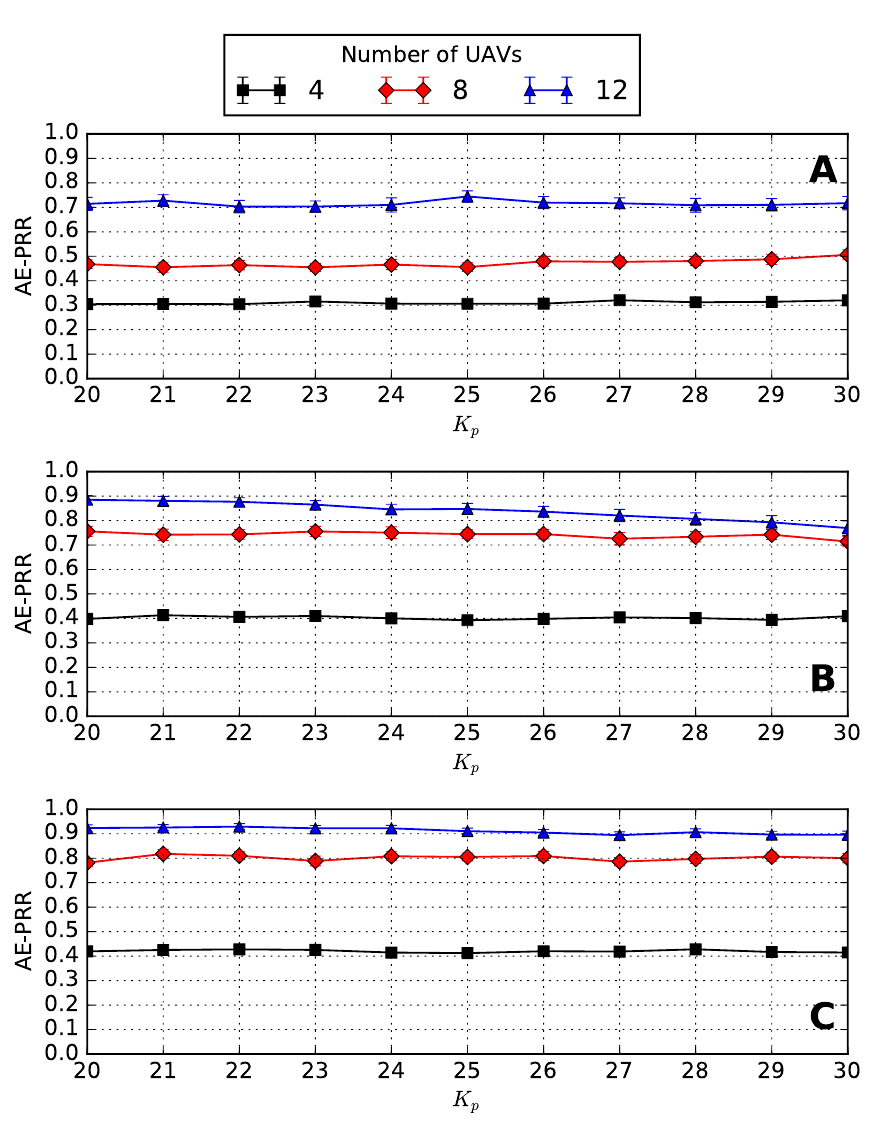
Figure 6. AE-PRR with VSF ( A ), VSF+CRM ( B ) and VSF+CRM+MP ( C ) (no team splits) in scenario with the same parameters of Section